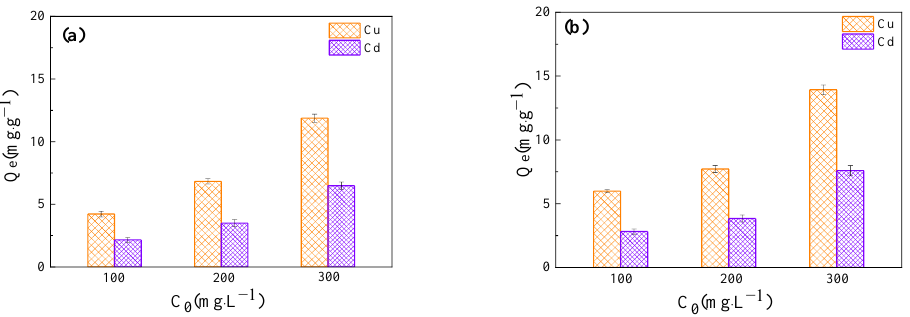
Figure 3. ( a ) Competitive adsorption diagram of dual heavy metals in Soil-A; ( b ) Competitive adsorption diagram of dual heavy metals in